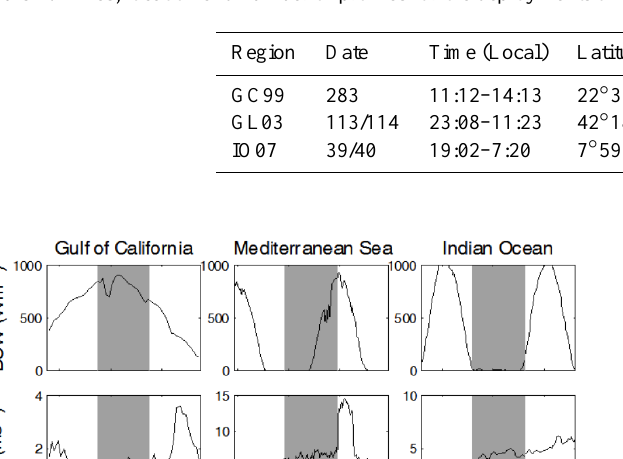
Table 1. Times, location and number of profiles for the deployments of the three case studies.